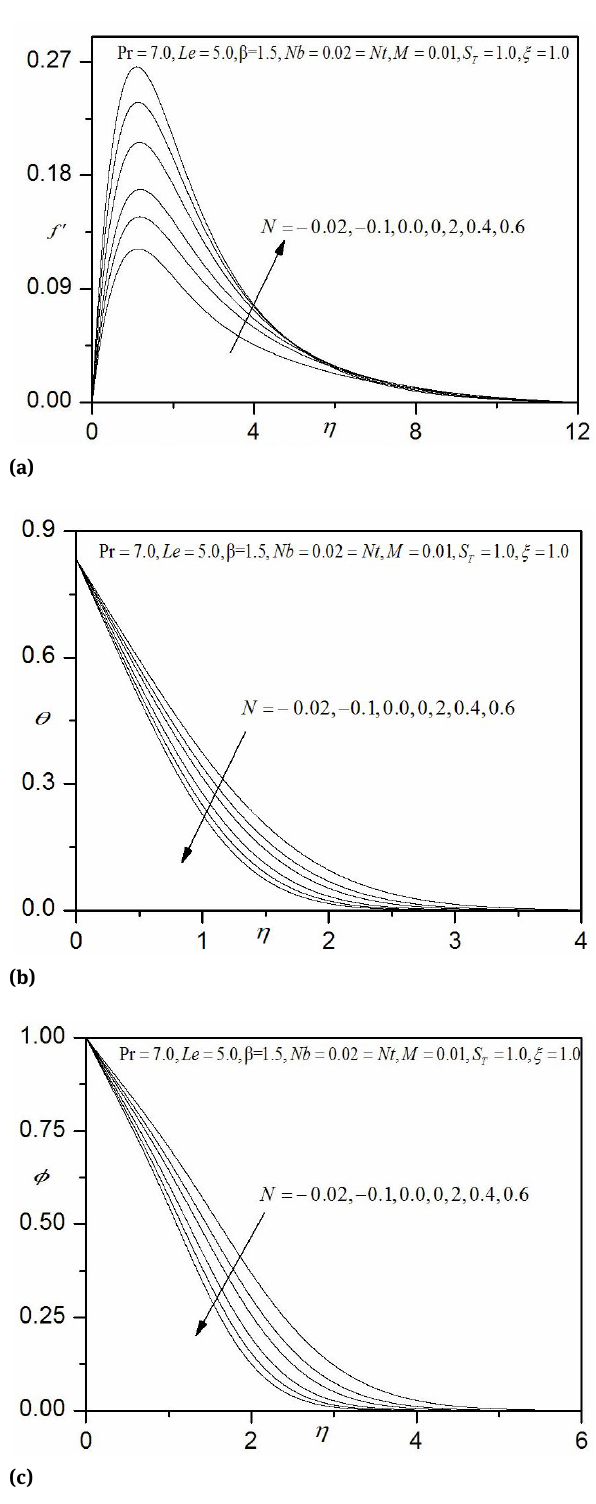
Fig. 10: Effect of N on (a) velocity profiles, (b) temperature